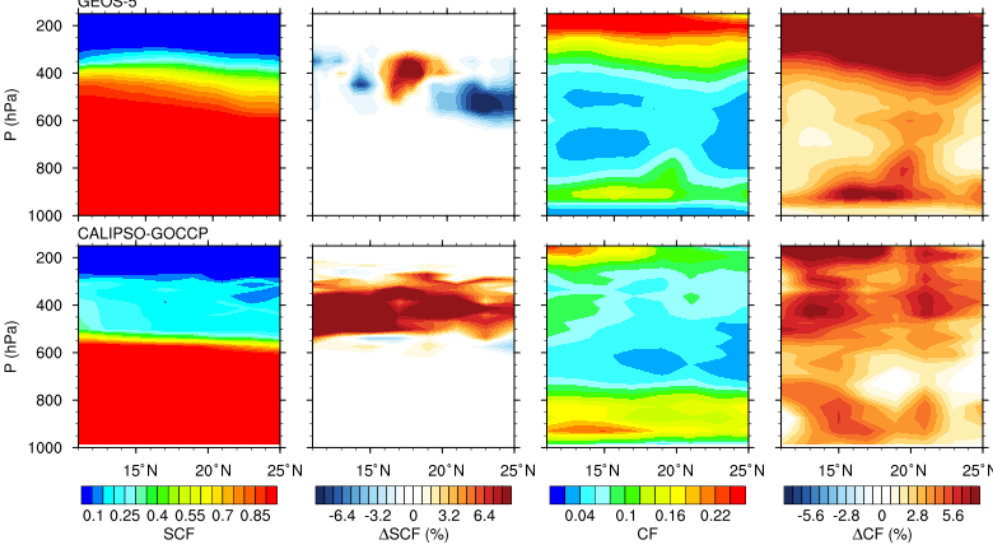
Figure 5. Like Fig. 4 but for MJJ